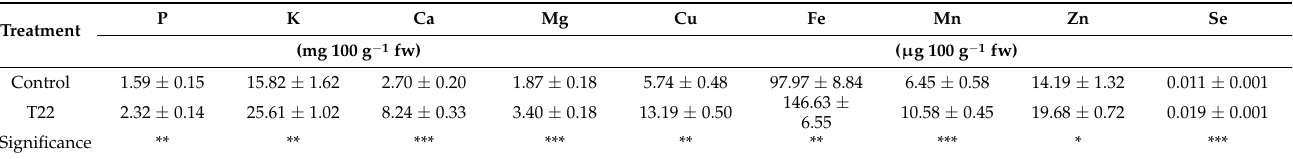
Table 1. Macro- and micronutrients’ content of Pixel tomato fruits under control or T. harzianum strain T22 biostimulant